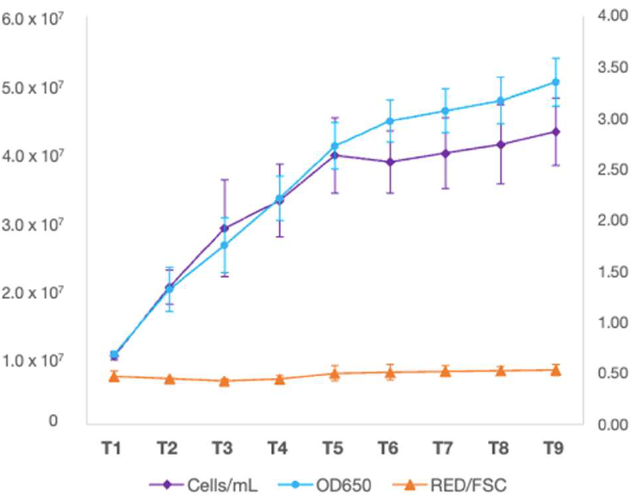
Figure 3. Micractinium rhizosphaerae NFX-FRZ growth dynamics when cultivated in algae culture broth (1.5×) for 9 days.